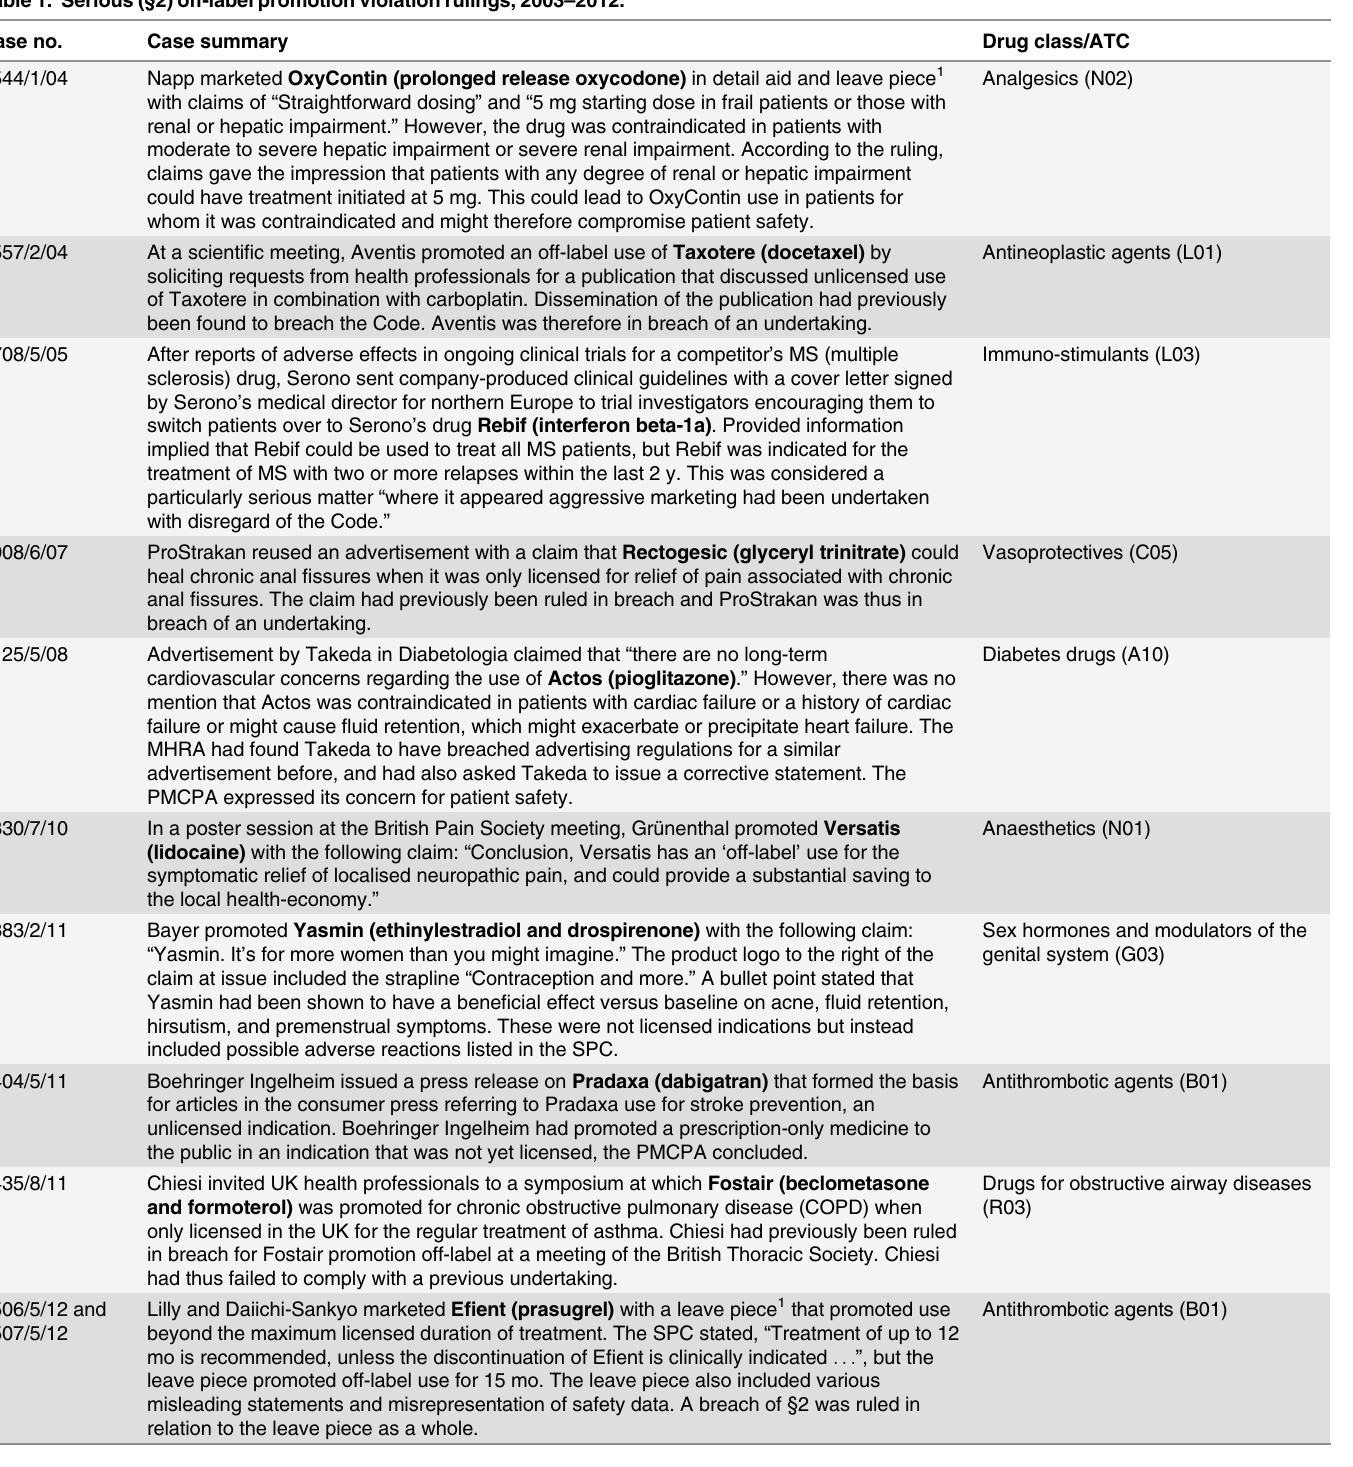
Table 1. Serious (§2) off-label promotion violation rulings, 2003 – 2012. Case